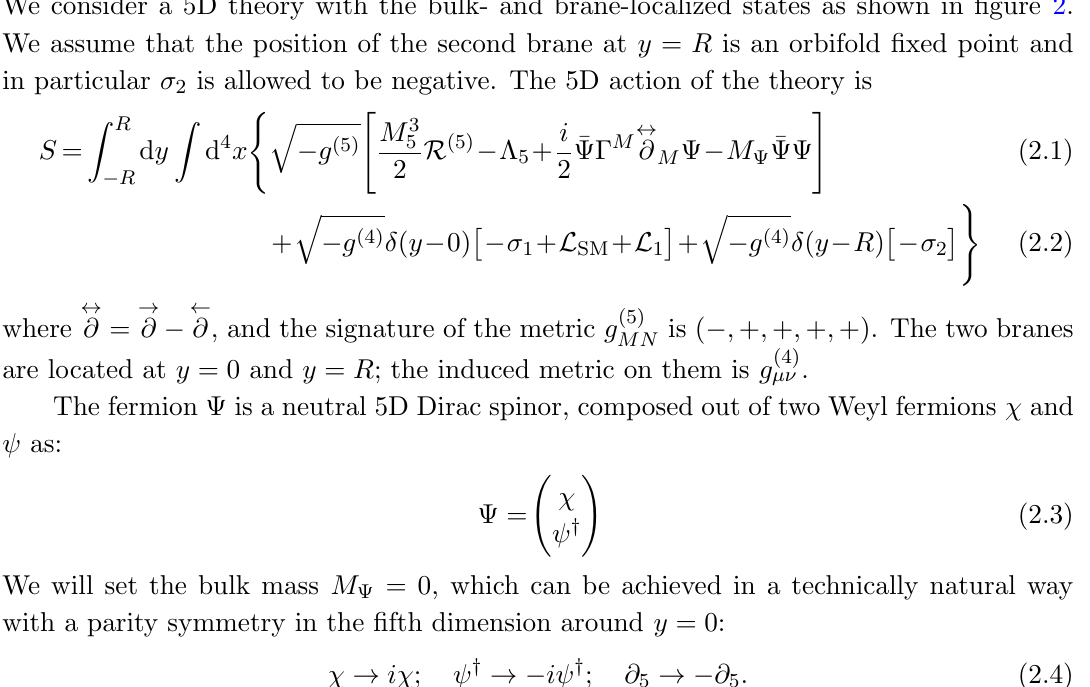
Table 1 . The charges of the new states L ( L c ) and N 1 ( N c SU(2) L U(1) Y gauge (cid:2)